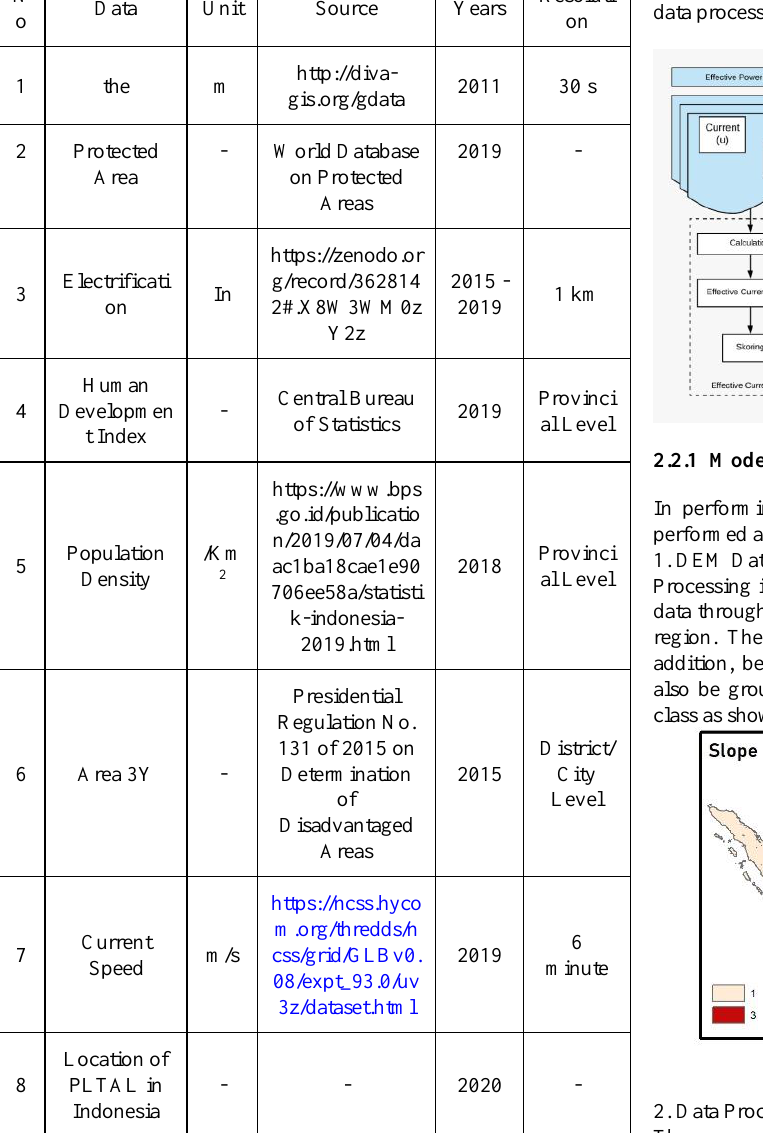
Figure 2 Scoring For Slope